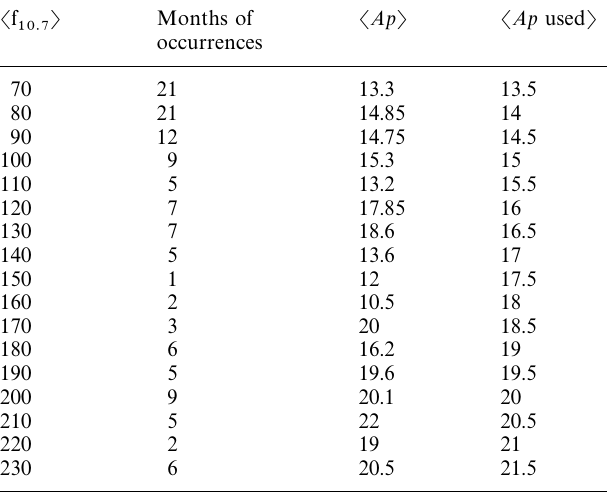
Fig. 8. Same as Fig. 7 above ESR The coefficients a , b , and c are given in Table 3